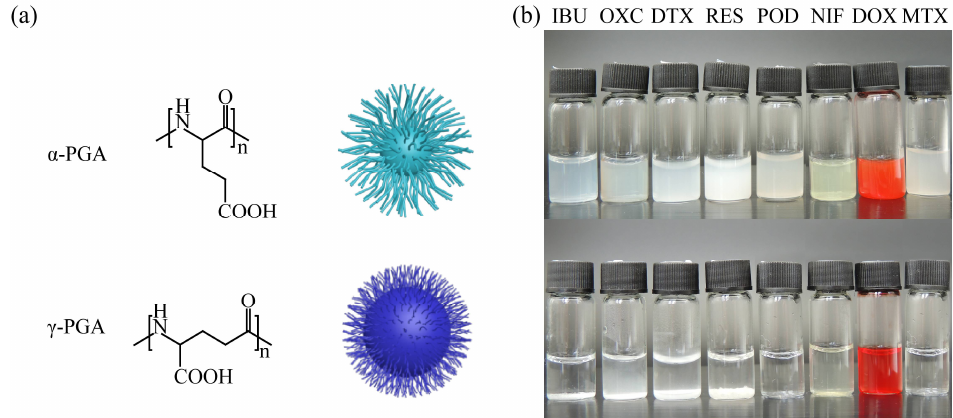
Figure 1. Structure of PGA and their aggregates ( a ), images of drug-loaded NPs ( b Figure 1 . Structure of PGA and their aggregates ( a ), images of drug-loaded NPs ( b ).